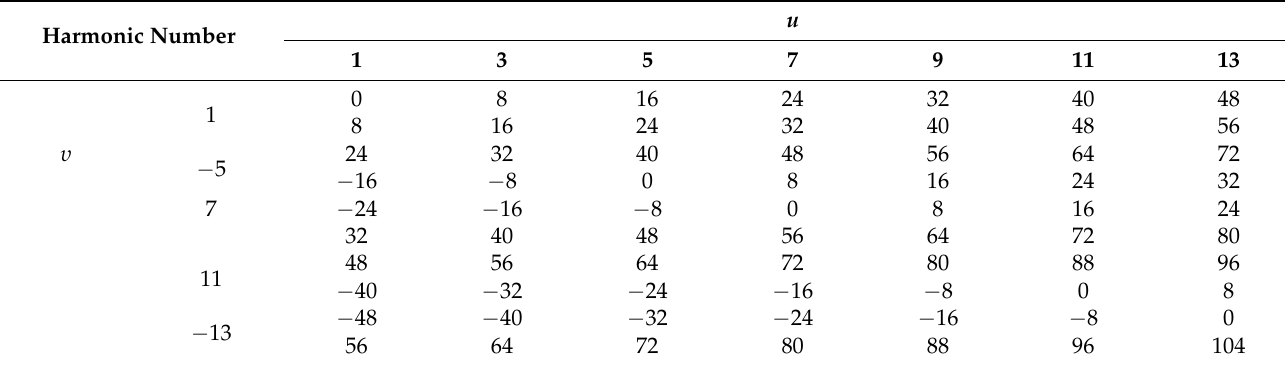
Table 4. Number of electromagnetic force